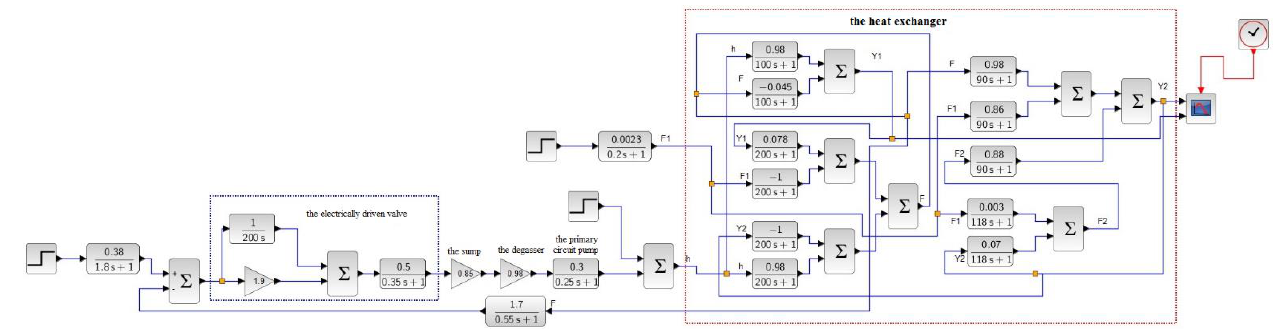
Figure 6. Scheme for studying the temporal characteristics of the automatic control system model for the heat carrier temperature of the heat exchanger of a heat supply system without acoustic–magnetic devices in the simulation environment Scilab 6.1.